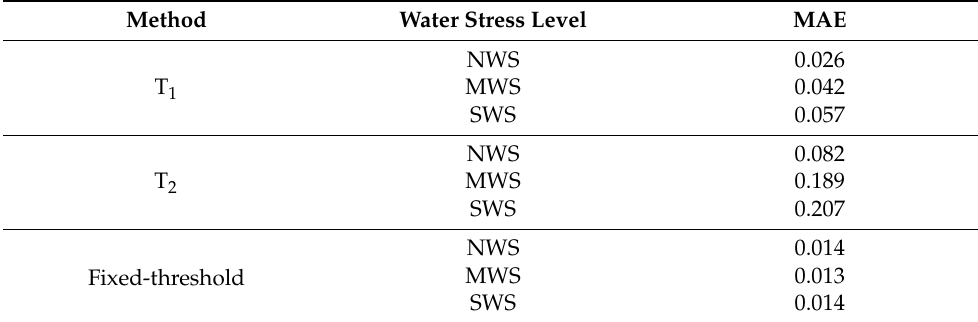
Table 6. The mean absolute errors (MAEs) obtained from plots with no water stress (NWS), interme- diate water stress (MWS), and severe water stress (SWS) using different methods.